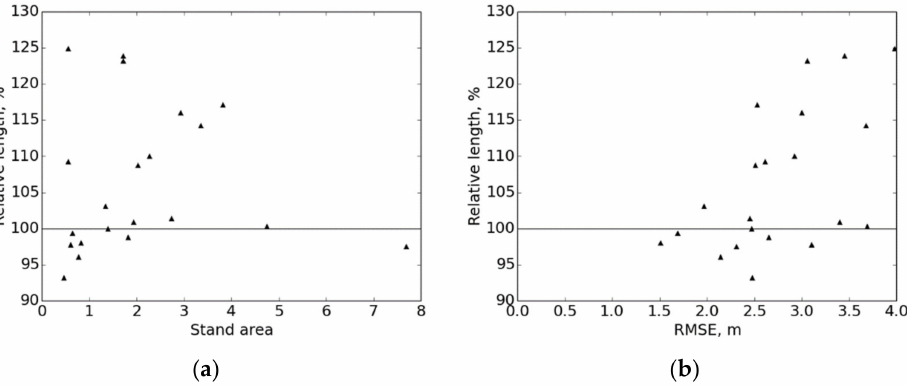
Figure 9. The lengths of the computed strip road networks with respect to the references. ( a ) The relative total length as a function of the area of the harvested stand.; ( b ) the relative total length as a function of RMSE of the displacement distances between the two strip road networks.